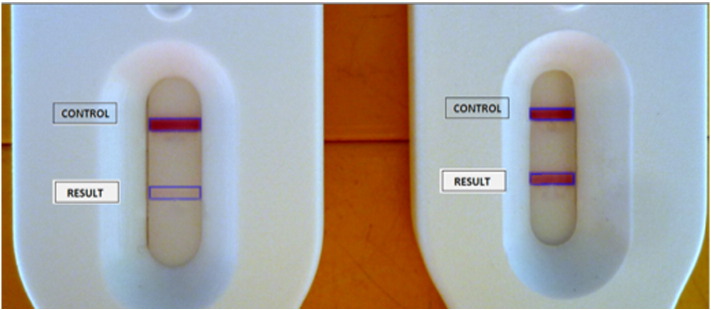
Pixel quantification of two POC-CCA tests. Detailed picture from two cassettes with their control and result bands. To the left, POC-CCA shows a visual ‘trace’ score. To the right, POC-CCA shows a visual + 3.